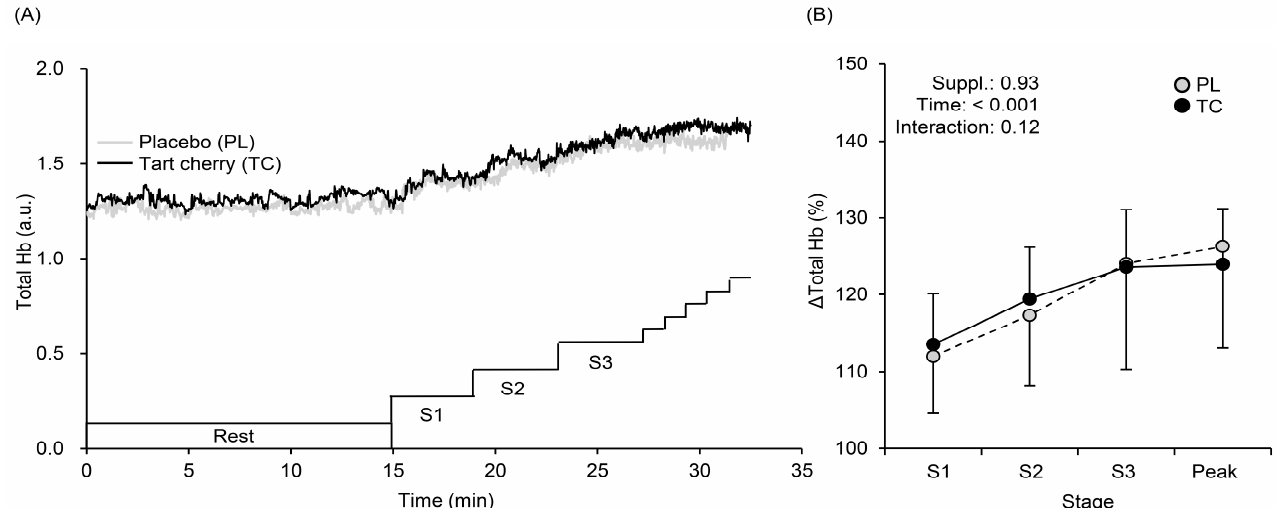
Figure 5. The typical time course changes in total hemoglobin (total Hb) profiles at rest and during exercise ( A ). Changes in mean total Hb with SD obtained at rest, at each stage (S1, S2, S3), and at exercise exhaustion (Peak) after 5 days of tart cherry (TC) and placebo (PL) supplementation ( B ).